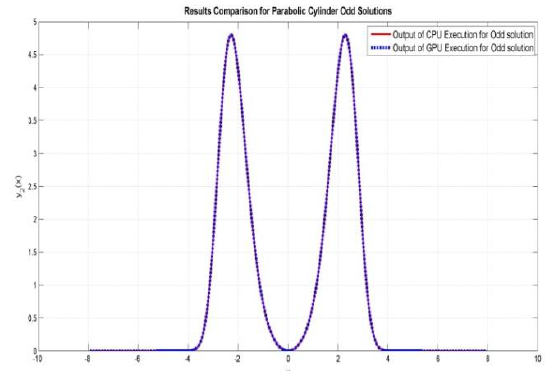
Fig. 3. Output Benchmarking plots of Odd Parabolic Cylinder function.